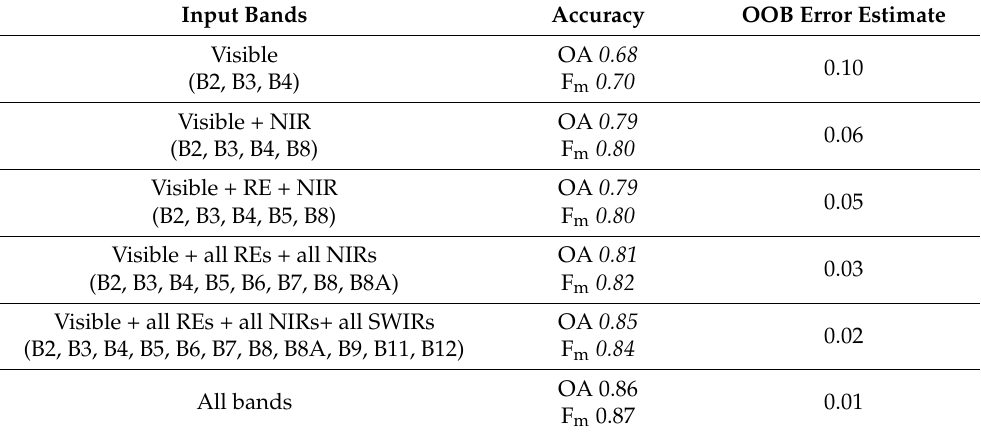
Table 5. The different combinations of bands adopted on the summer image composite (Su_IC) and the obtained accuracy information, expressed as overall accuracy (OA) and multi-class F-score (F m ). Moreover, the out-of-bag (OOB) error estimate values for the random forest (RF) algorithm are reported. Input Bands Accuracy OOB Error Estimate Visible OA 0.68 (B2, B3, B4) F m 0.70